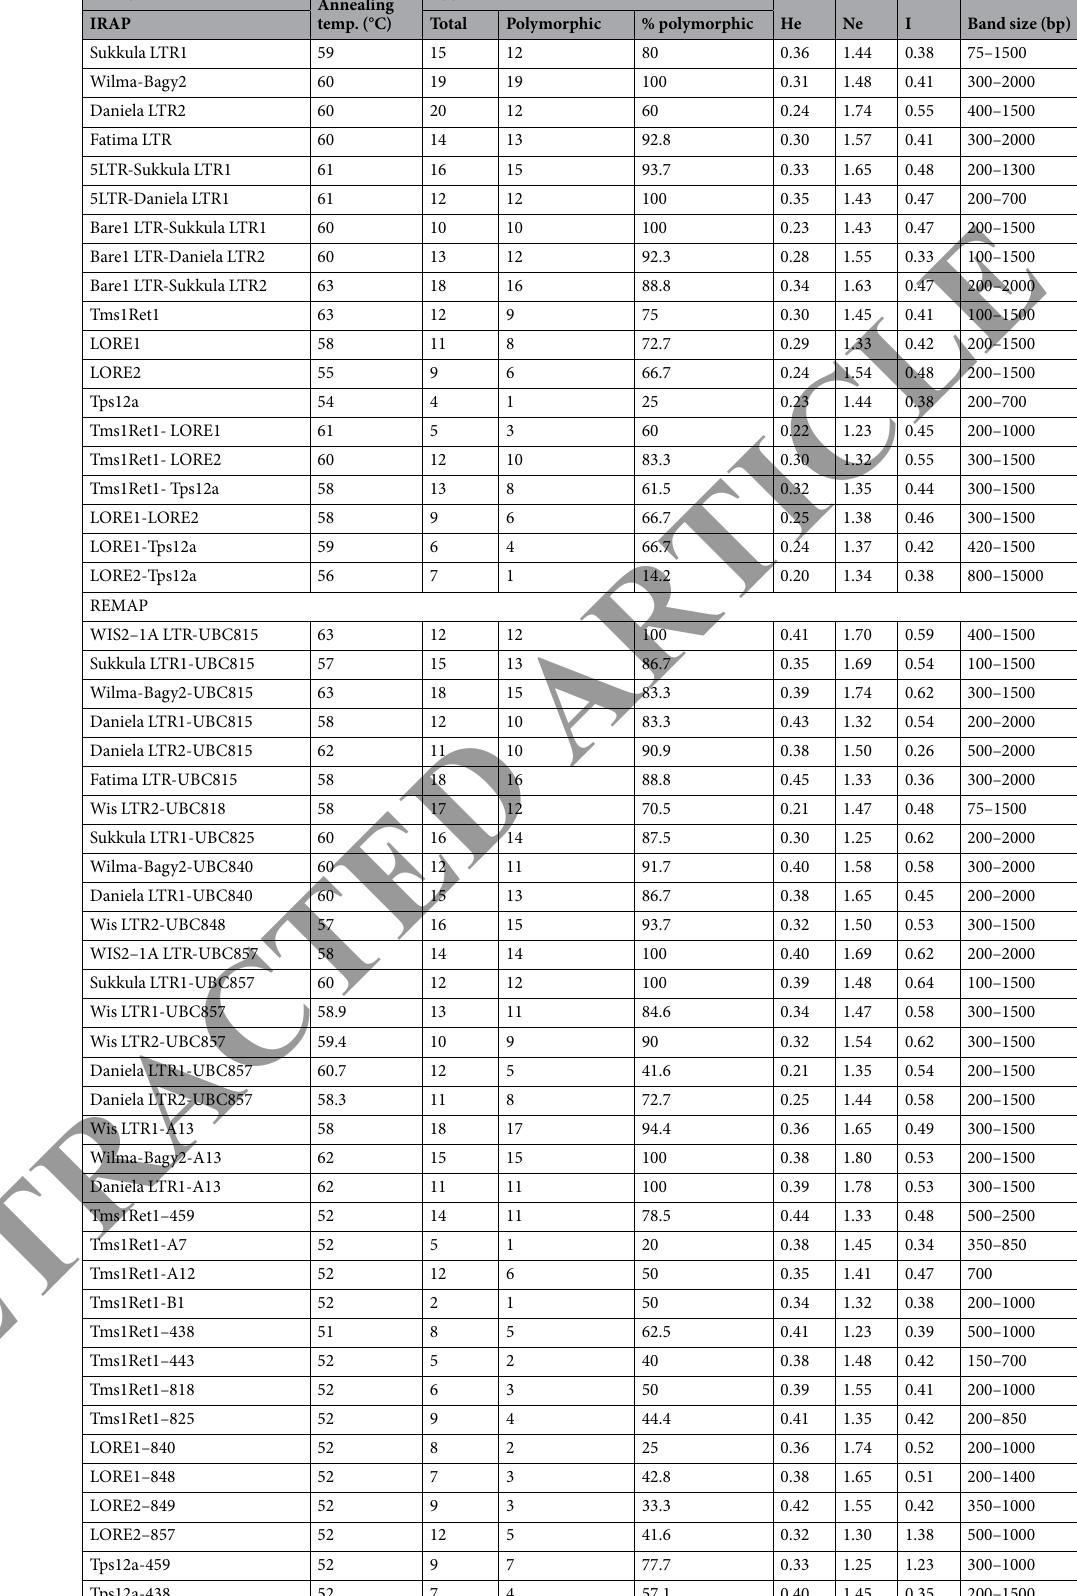
Table 2. IRAP and REMAP primer combinations used in this